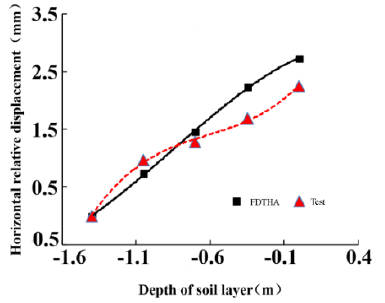
Figure 13. Time ‐ history analysis and horizontal relative displacement of model foundation in the shaking ‐ table test.